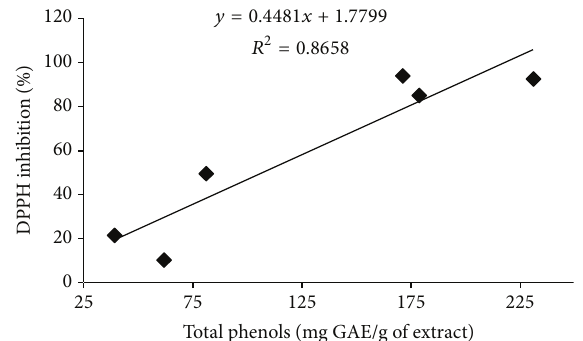
Figure 9: Correlation between total phenols and FRAP of leave extracts of Loranthus pulverulentus . y = 0.4481x + 1.7799